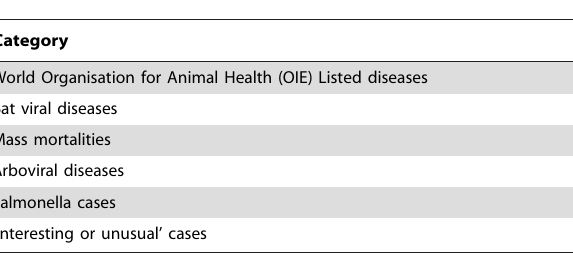
Table 2. Categories for selection of wildlife disease events for reporting into